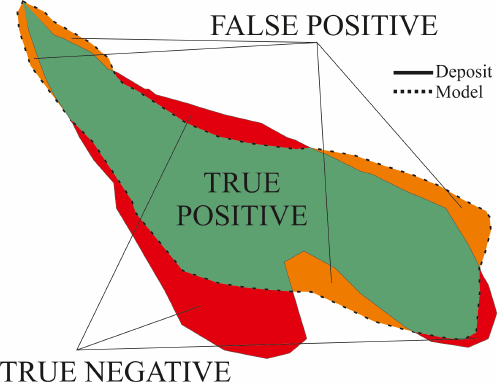
Figure 5. Sketch representing the three areas used for the valida- tion procedure (the model output outline is drawn as a dashed black